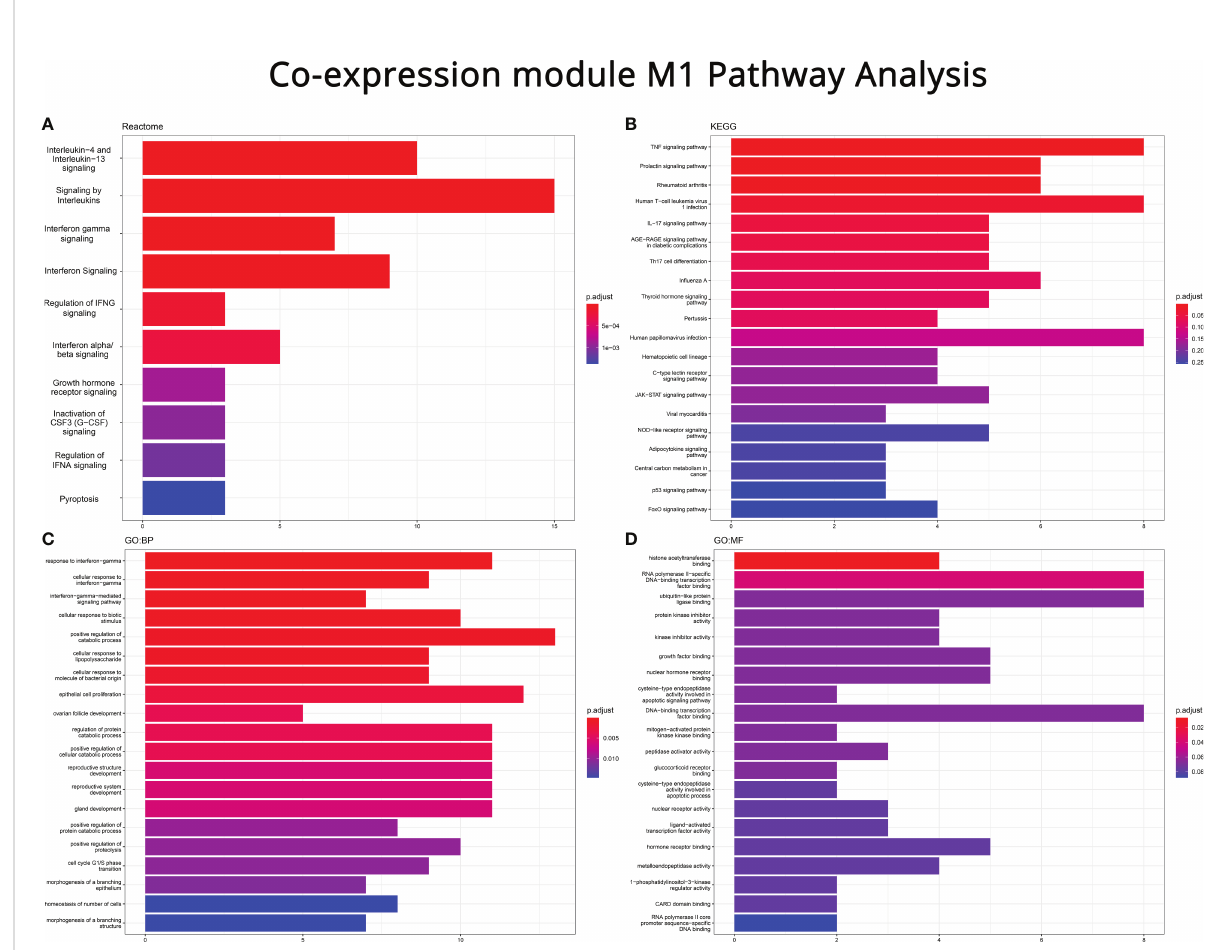
FIGURE 6 Pathway enrichment analysis on the M1 co-expression module genes (performed with R and the clusterPro fi ler package) using (A) Reactome, (B) Kyoto Encyclopedia of Genes and Genomes (KEGG), (C) Gene Ontology: Biological Process (GO:BP) and (D) Gene Ontology: Molecular Function (GO:MF). Top to bottom: most to least FIBSIg genes as a ratio of the pathway ’ s total number of